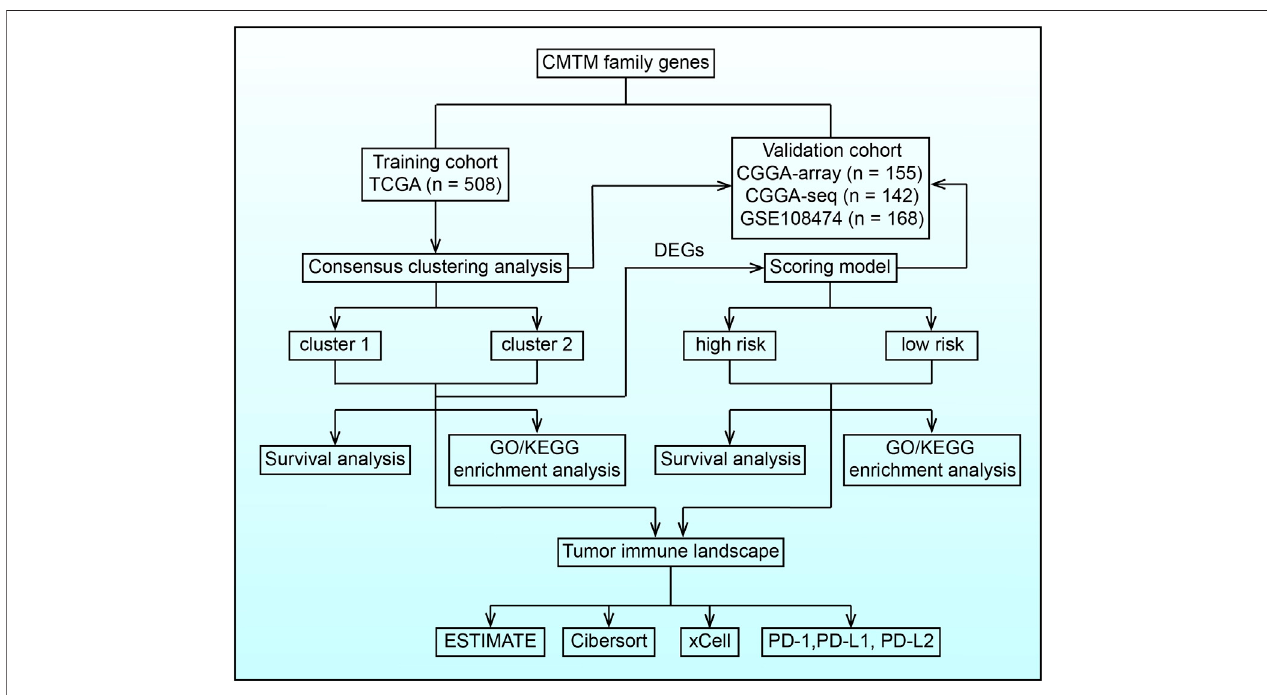
FIGURE 1 | Flow chart illustrating the proposed role of CMTM family genes in LGG.